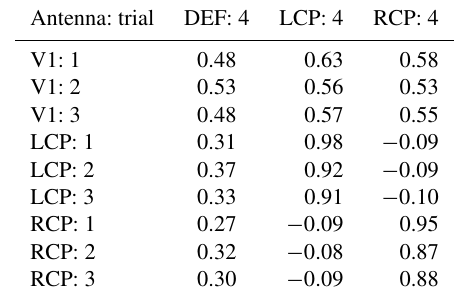
Figure 12. Imaginary part of the complex correlation coefficients for different antennas and measurement trial 4.